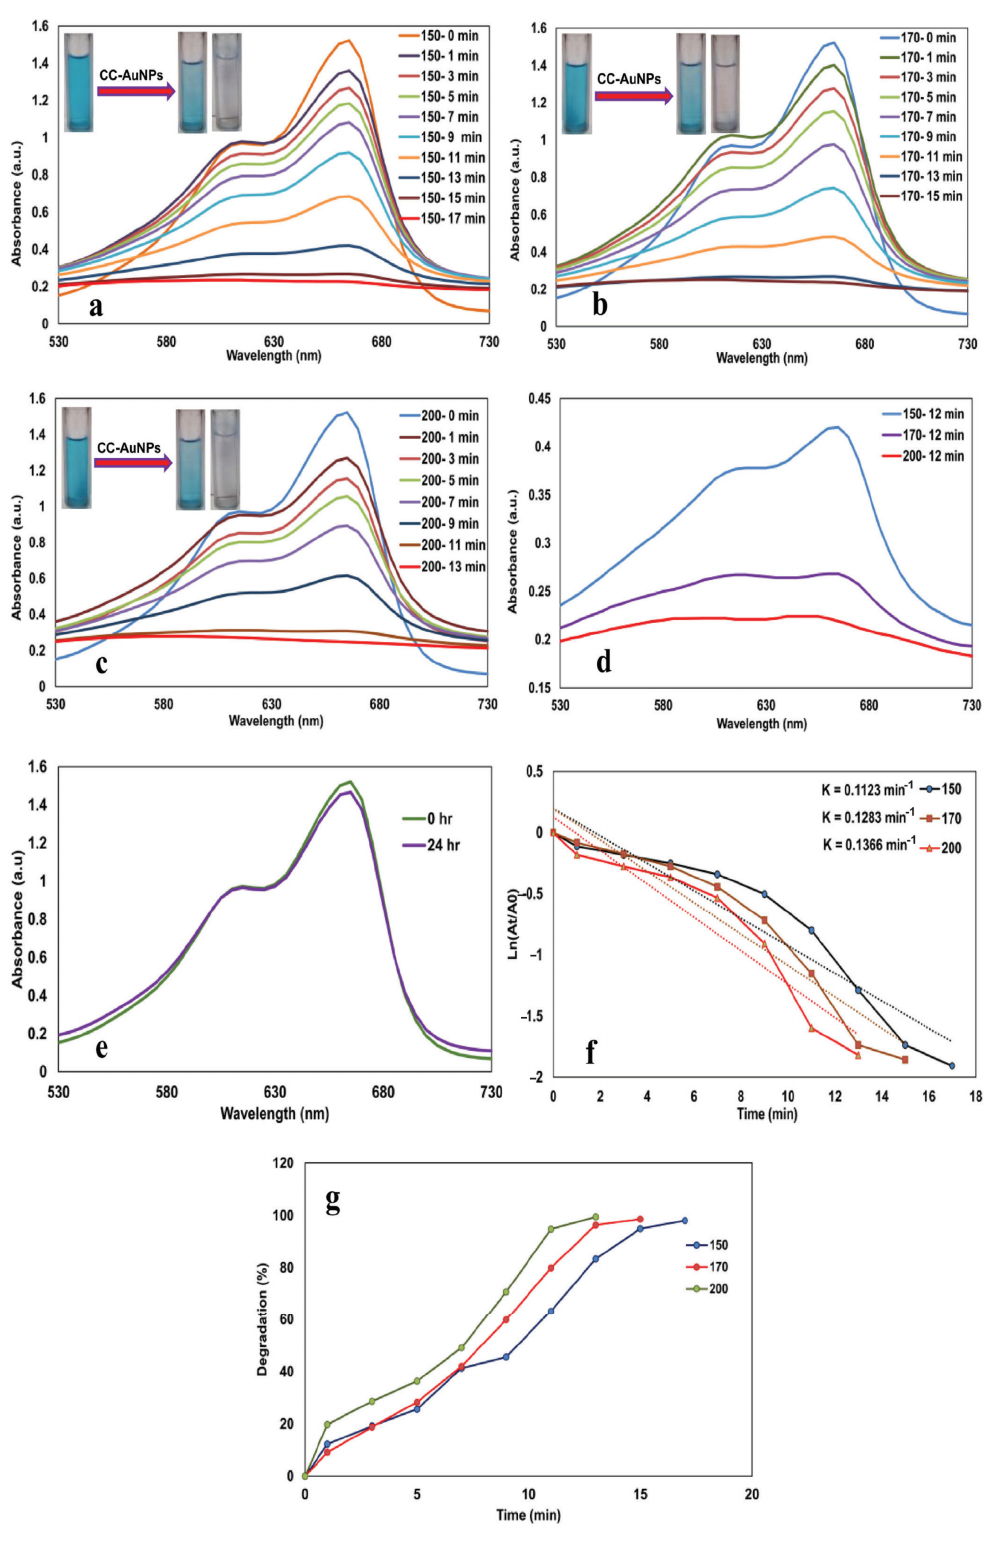
Figure 11. UV–Vis absorption spectra for the MB reduction with NaBH 4 catalyzed by ( a ) 150 µ L, ( b ) 170 µ L, and ( c ) 200 µ L of CC-AuNPs (425 µ g/mL), ( d ) the comparison of different volumes of CC-AuNPs. ( e ) UV–Vis spectra for the MB reduction with NaBH 4 only, without nanocatalyst, ( f ) the corresponding plots of ln(At/A0) vs time, ( g ) degradation percentage of